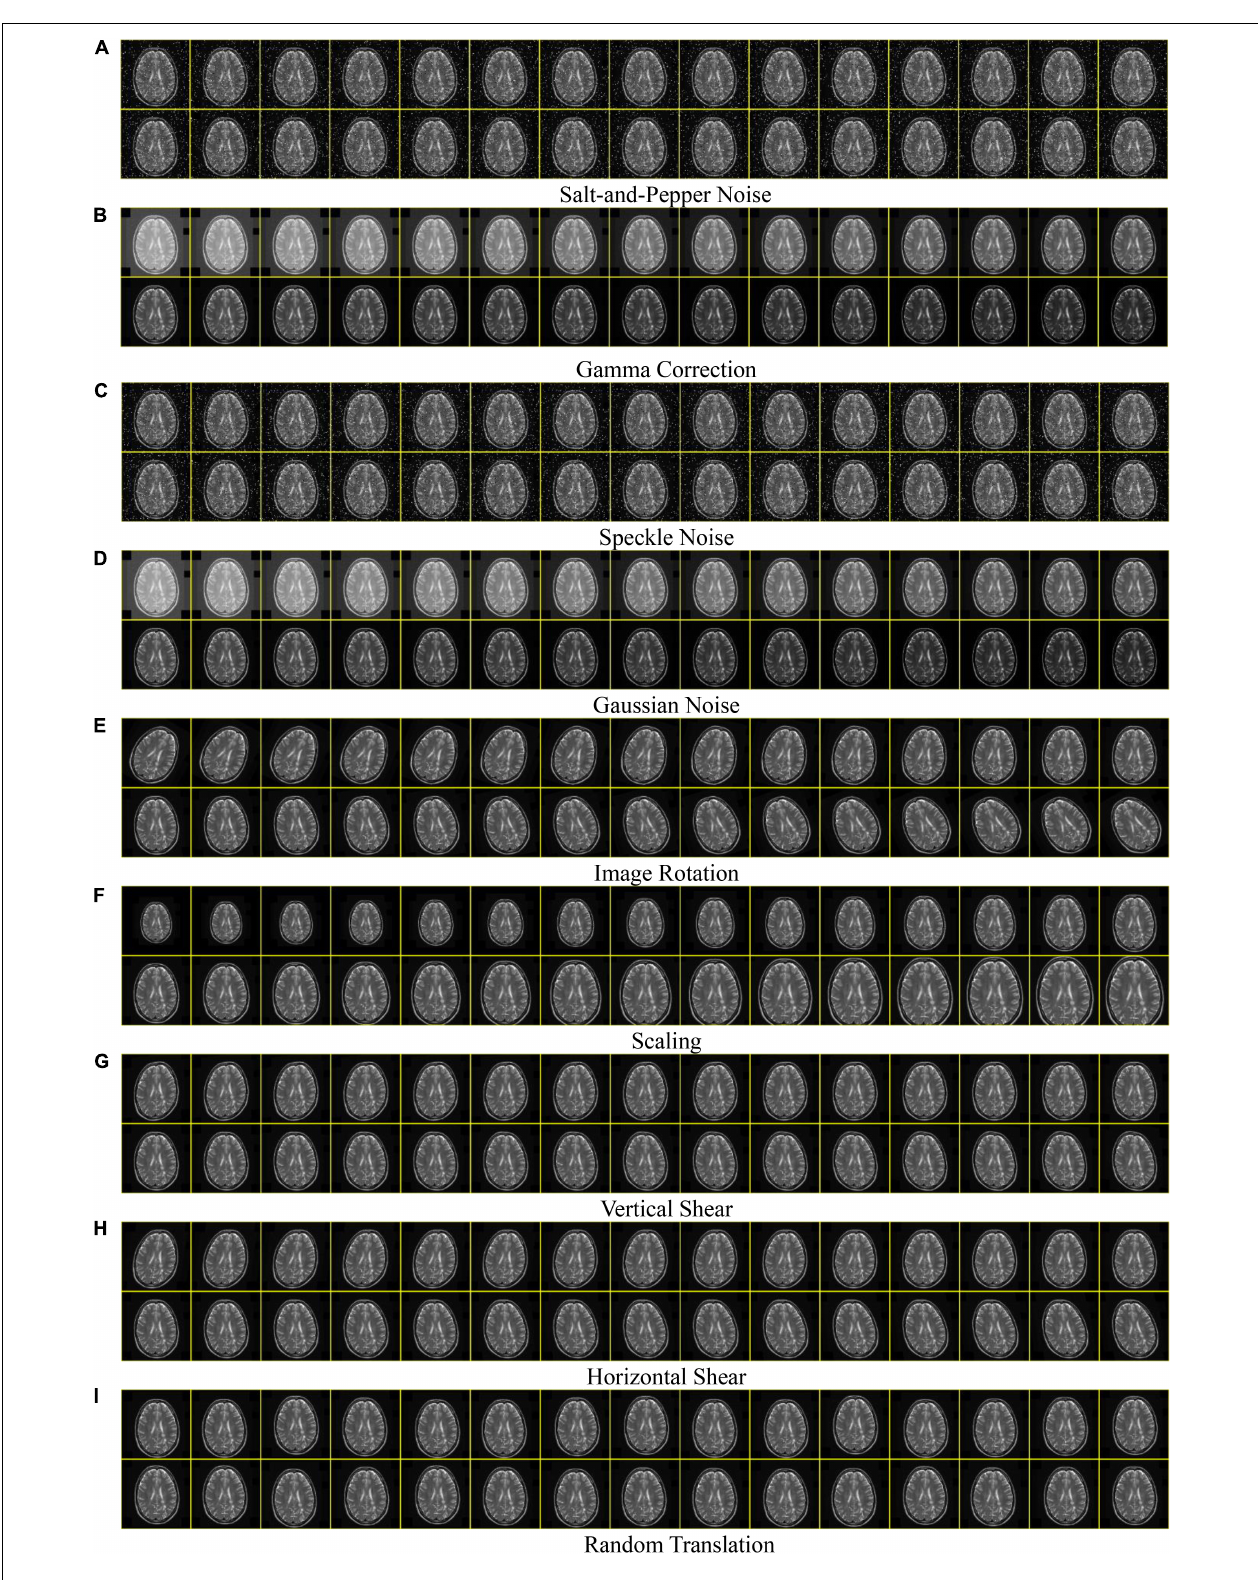
FIGURE 10 | Results of Multiple-way DA. (A) Salt-and-Pepper Noise. (B) Gamma Correction. (C) Speckle Noise. (D) Gaussian Noise. (E) Image Rotation. (F) Scaling. (G) Vertical Shear. (H) Horizontal Shear. (I) Random Translation.